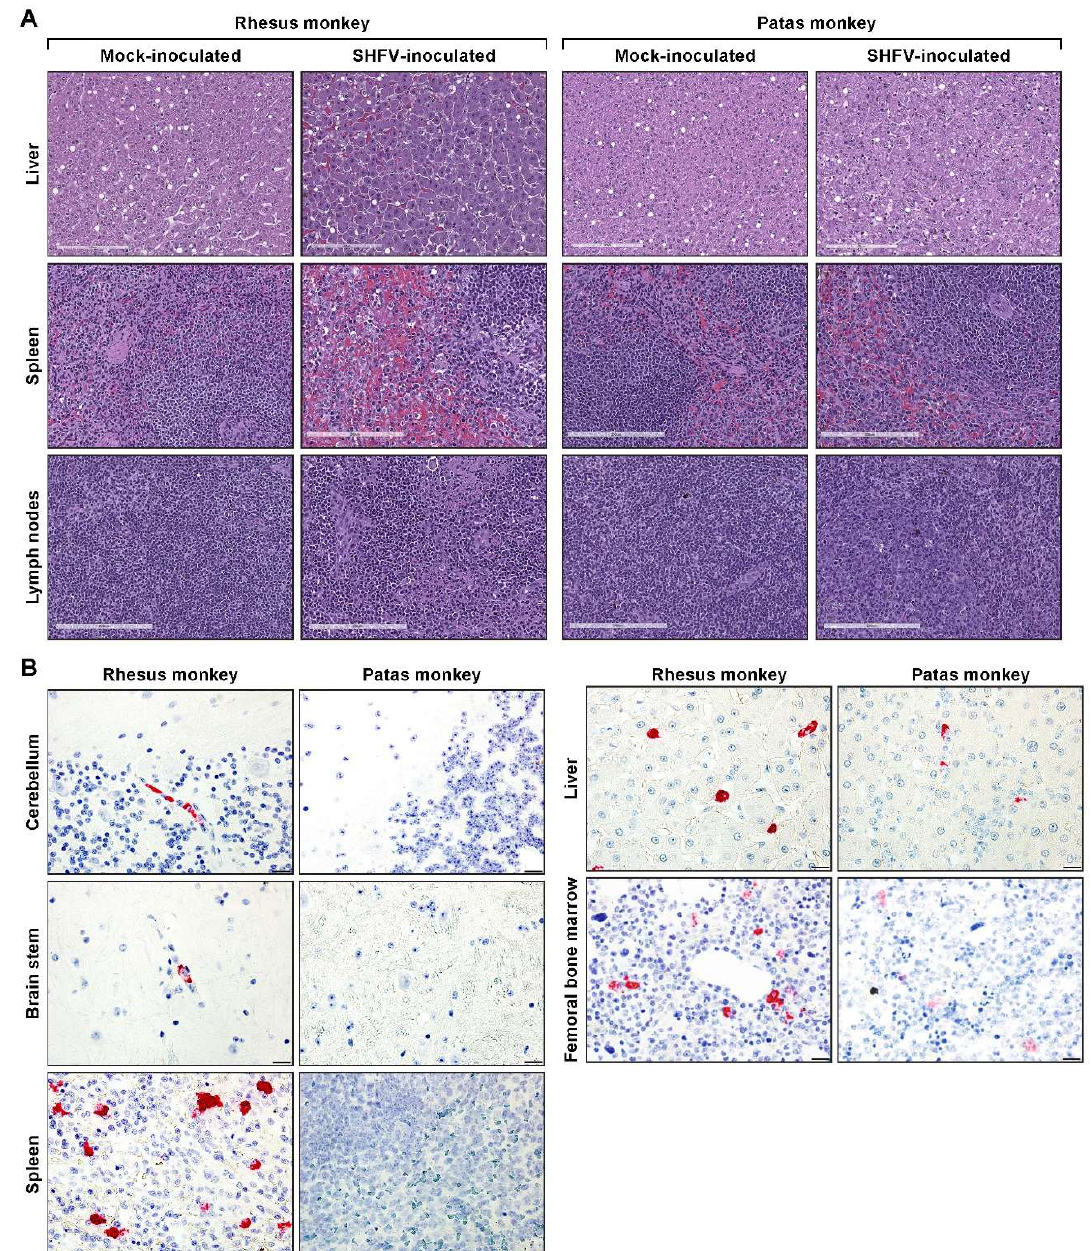
Figure 2. Representative images of hematoxylin- and eosin- (H&E) stained livers, spleens, and lymph nodes of mock- and SHFV-inoculated patas and rhesus monkeys ( A ). Representative images of in situ hybridization used to detect SHFV RNA in terminal cerebellum, brain stem, spleen, femoral bone 50 µ m ( B marrow, and liver samples from patas and rhesus monkeys ( B ). Scale bars represent 200 µm ( A ) and 50 µm ( B ).